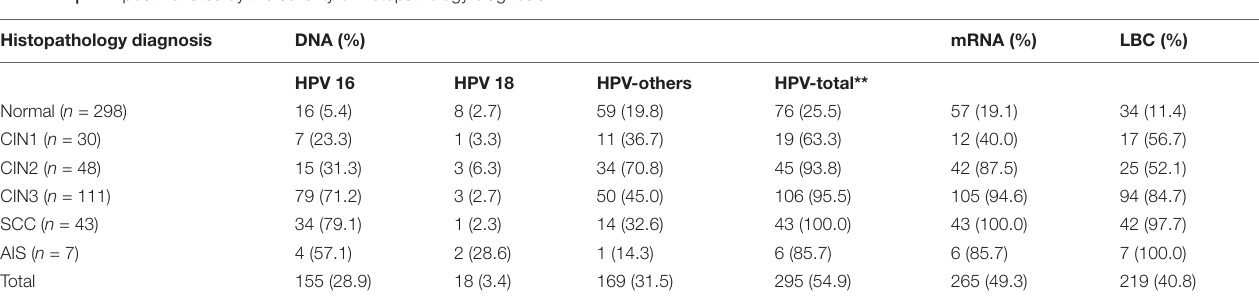
TABLE 2 | HPV positive rates by the severity of histopathology diagnosis.